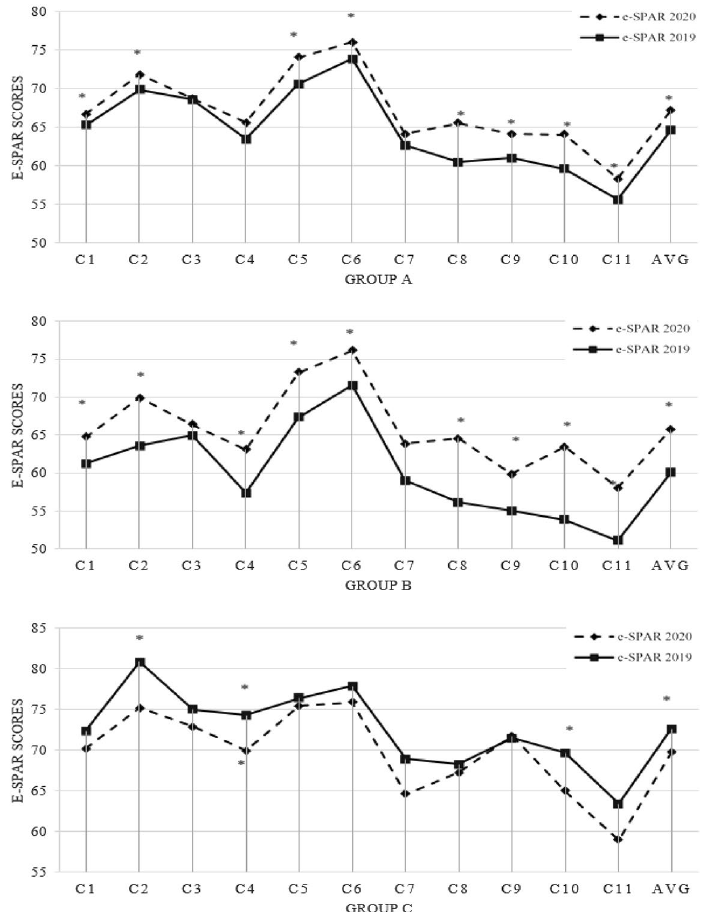
Figure 1. The countries’ e-SPAR capacity scores in 2020 and 2019; asterisk: capacity with significant change (p < 0.05). Group A: 154 countries, Group B: 98 countries whose score increased, Group C: 56 countries whose score did not increase . Capacity: Legislation and financing (C1), IHR coordination and National IHR focal point function (C2), Zoonotic events and the human-animal interface (C3), Food safety (C4), Laboratory (C5), Surveillance (C6), Human Resources (C7), National Health Emergency Framework (C8), Health Service Provision (C9), Risk communication (C10), Points of entry (C11), Average of 11 capacities (AVG). This figure showed the countries’ e-SPAR capacity scores in 2020 and 2019. Among all 154 countries (group A), the average of 11 e-SPAR capacity scores as well as the scores for each capacity in 2020 were higher than their respective scores in 2019. From 2019 to 2020 the scores increased from 0.13 to 5.04. From the test, it’s known that within this group, capacities about Zoonotic events and the human-animal interface, Food Safety, and Human Resources (p > 0.05) were the three capacities that were significantly different. Next, among 98 countries whose scores increased (group B), the test result showed that the average score of the 11 capacities increased significantly from 2019 to 2020. Risk communication, National Health Emergency Framework, and Ports of entry were the 3 capacities that mostly increased (p < 0.05). In this group, the capacity of Zoonotic events and the human-animal interface was the only capacity that was not significantly changed during the pandemic (p > 0.05). Meanwhile, among 56 countries whose scores did not improve (group C), the test result showed the average score of the 11 capacities decreased significantly, as well as the capacity for National IHR focal point function, Food Safety, and Risk Communication (p < 0.05). Meanwhile, other capacities were not significantly changed during the first year of the COVID-19 pandemic, including capacity related to zoonotic disease